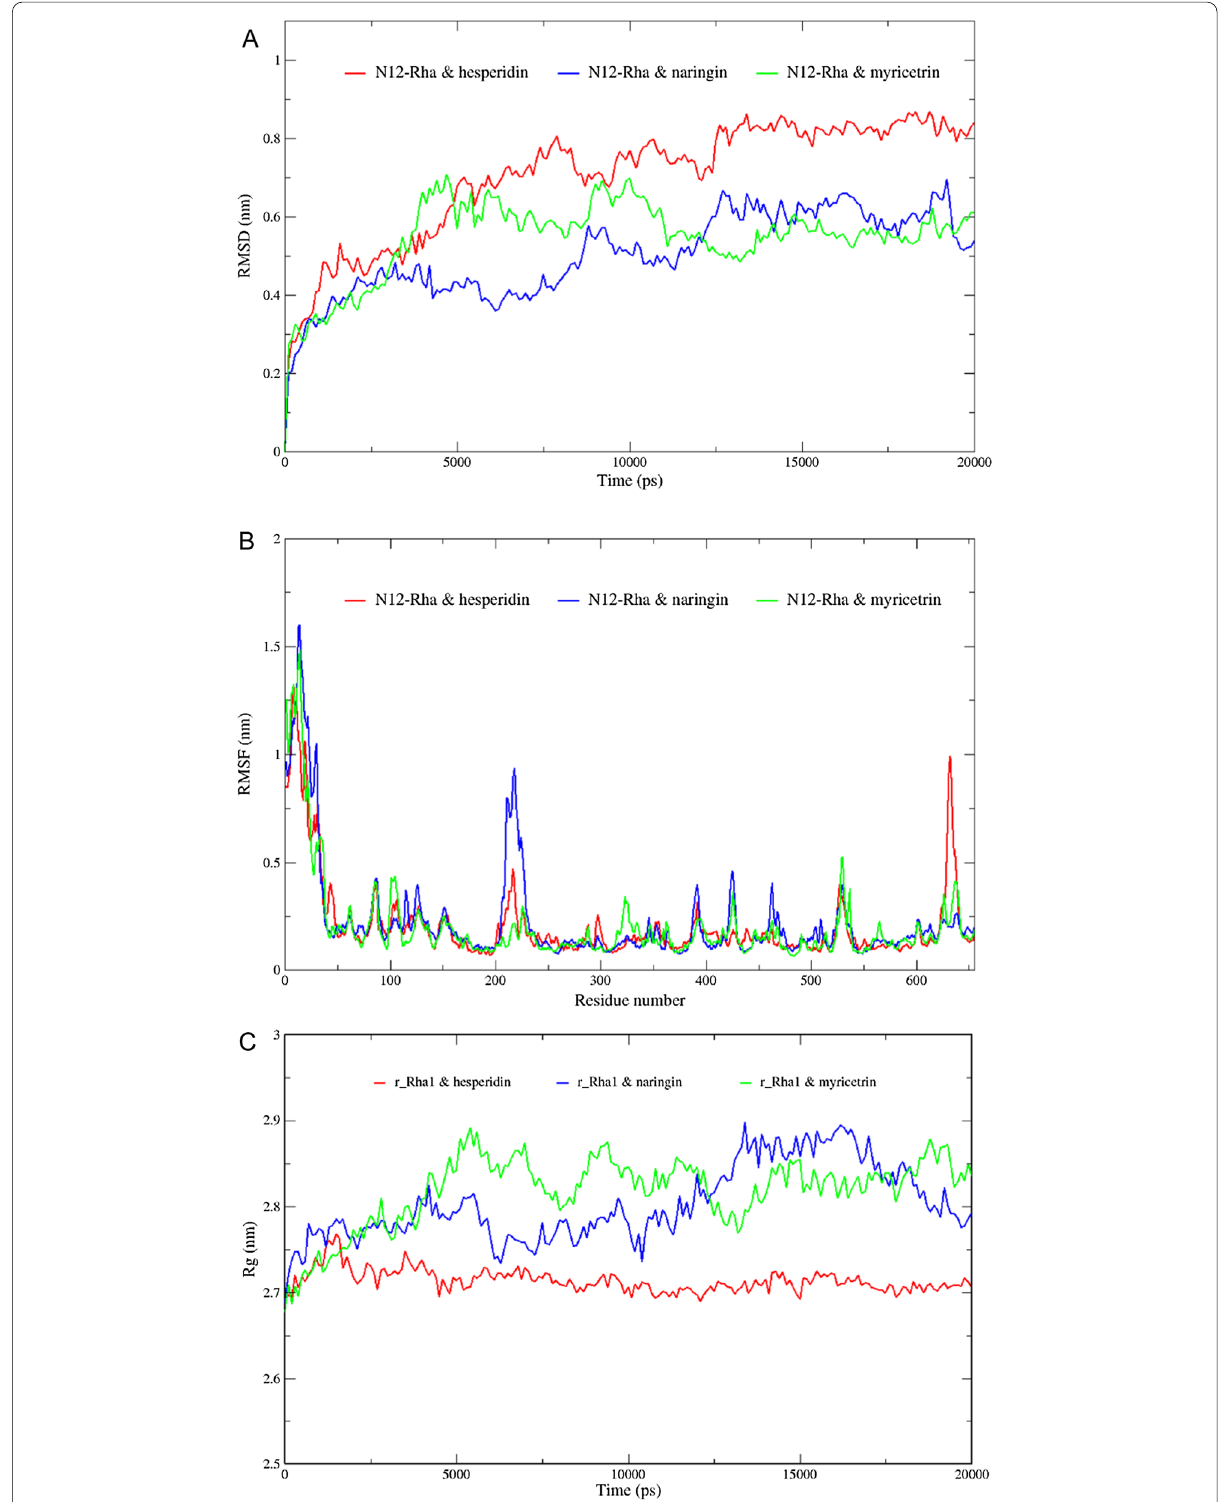
Fig. 5 The RMSD ( A ), RMSF B and Rg C of N12-Rha binds to hesperidin, naringin and myricetrin in MD